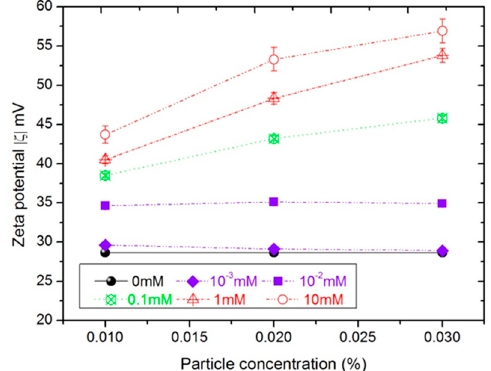
Figure 6. The zeta potential as a function of particle concentration at different AOT concentrations and a PS particle size of 535 nm.